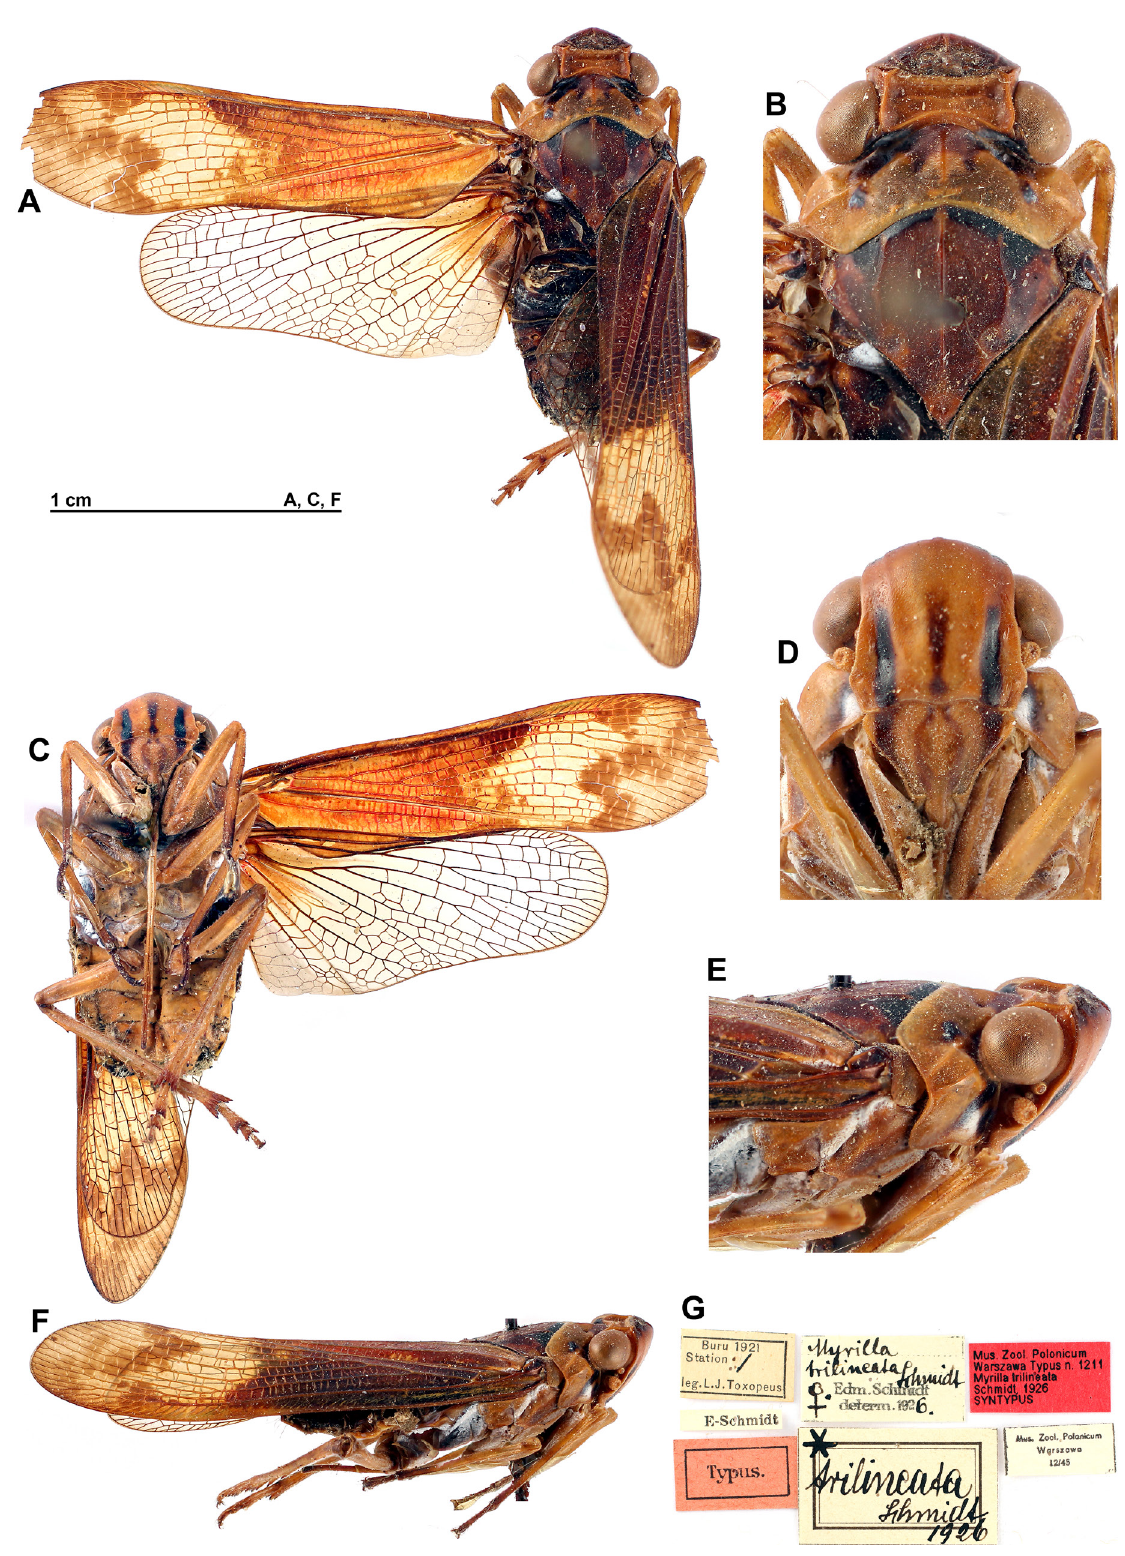
Fig. 7. Birdantis trilineata (Schmidt, 1926), lectotype, ♀. A . Habitus, dorsal view. B . Head and thorax, dorsal view. C . Habitus, ventral view. D . Head, normal view of frons. E . Head and thorax, lateral view. F . Habitus, lateral view. G . Labels. B, D, E not to